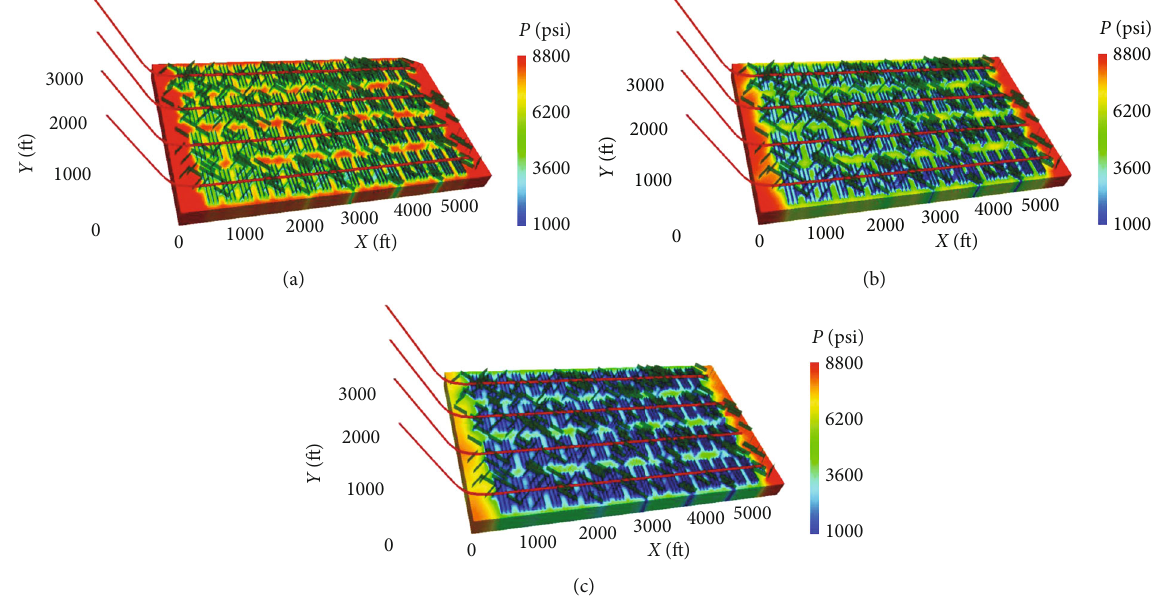
Figure 15: Pressure distributions in the matrix for the optimal well spacing scenario: (a) after 1 year, (b) after 5 years, and (c) after 20 years.